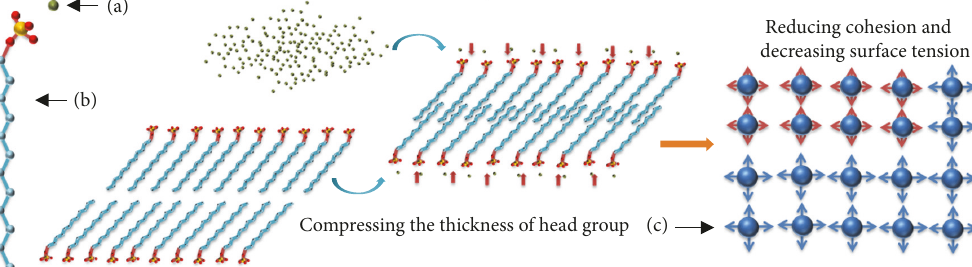
Figure 7: The effect of NaCl on SDS. (a) The sodium counterion, (b) SDS molecule, and (c) water